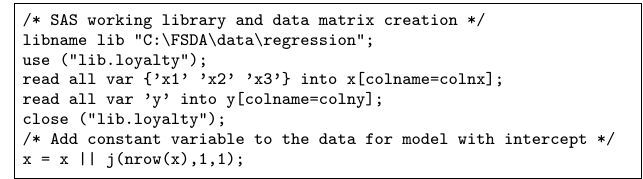
Figure 1. Example of the SAS IML Studio code which uploads the loyalty card data in SAS IML. Atkinson and Riani [7] show that the Box–Cox transformation can achieve approxi- mate normality for the response and Perrotta et al. [1] recommend a value of 0.4 for the transformation parameter λ . We work with this value throughout this